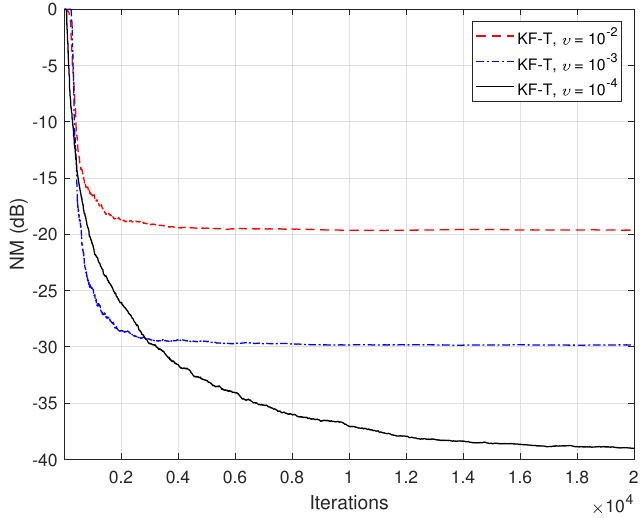
= 0, n = 1,2, . . . , N for the iden- n